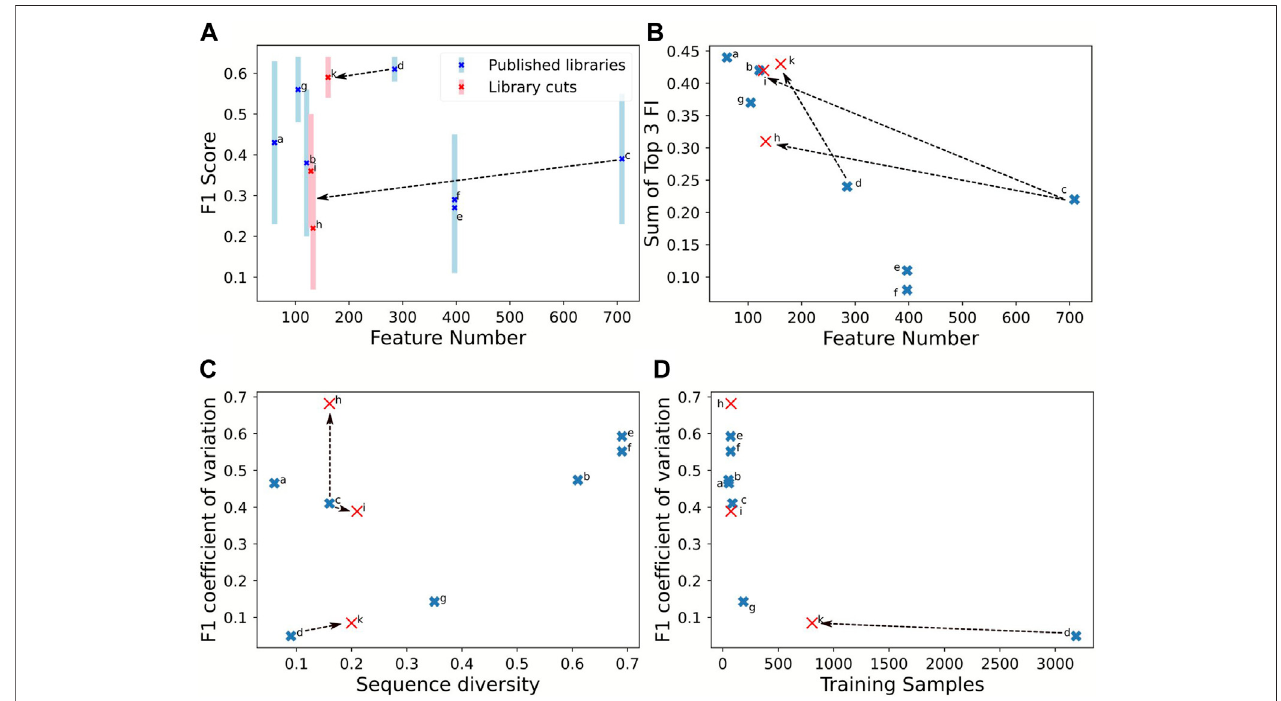
FIGURE 4 | Comparison of library properties on classi fi cation quality parameters for an estimation using RF. The estimations were performed on the training set of each library with 9:1 cross-validation. The seven fulllength promoter libraries are listed in Table 3 . Moreover, sub-sequences of40 nt were extracted from the promoter start ( h ) and end ( i ) of Meng et al. (2013)( c ) and start ( k ) of Zhao et al. (2020)( d ). F1-score (A) and the sum of the top three feature importance values (B) in response to feature amount. The coef fi cient of variation of the F1-scores in response to sequence diversity (C) and amount of training samples (D) . Full table with numerical values in the Supplementary Data